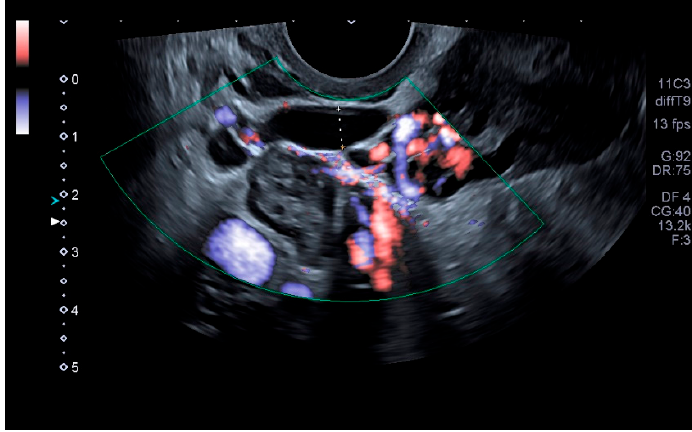
Figure 2. Largest pelvic vein diameter measurement.